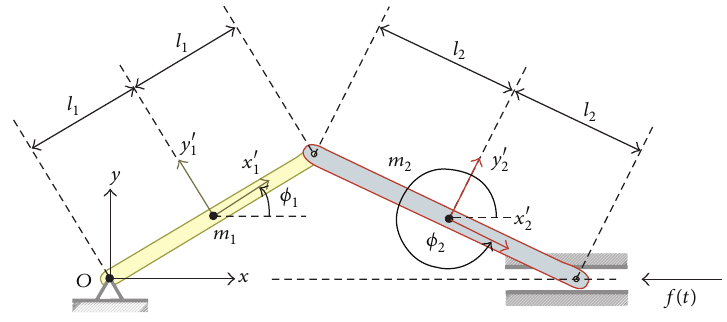
Figure 1: Planar slider-crank